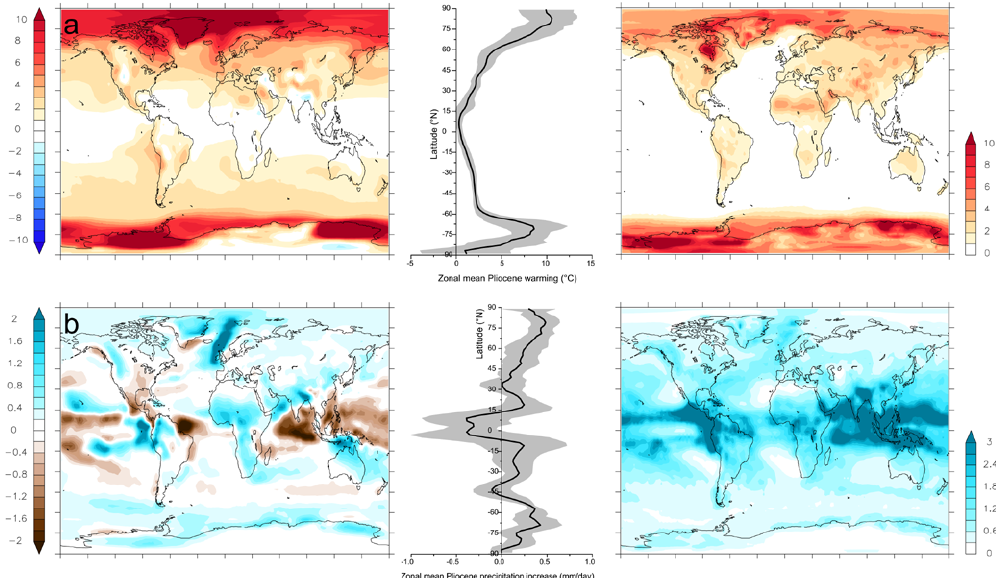
Fig. 2. Multi-model means, zonal means and model 2 σ from the Experiment 1 ensemble. (a) Mean annual surface air temperature anomaly (Experiment 1 Pliocene minus pre-industrial control) and (b) mean annual total precipitation rate anomaly (Experiment 1 Pliocene minus pre-industrial control). Shading around the zonal mean is the model 2 σ